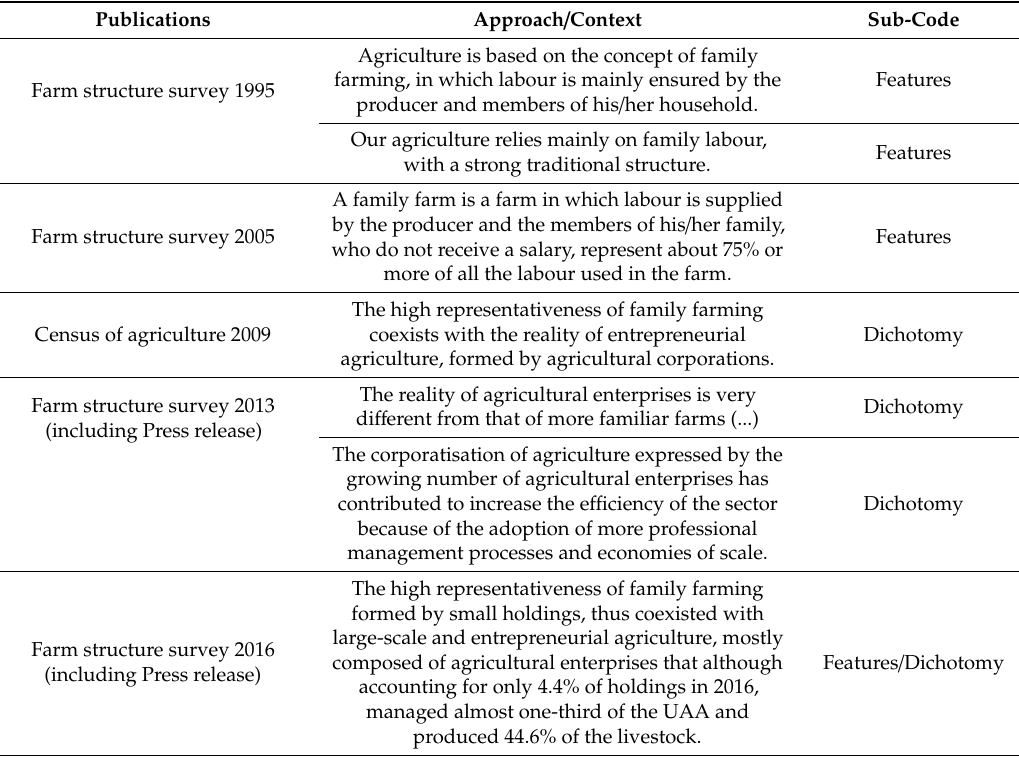
Table 5. References to family farming in Statistics Portugal publications.